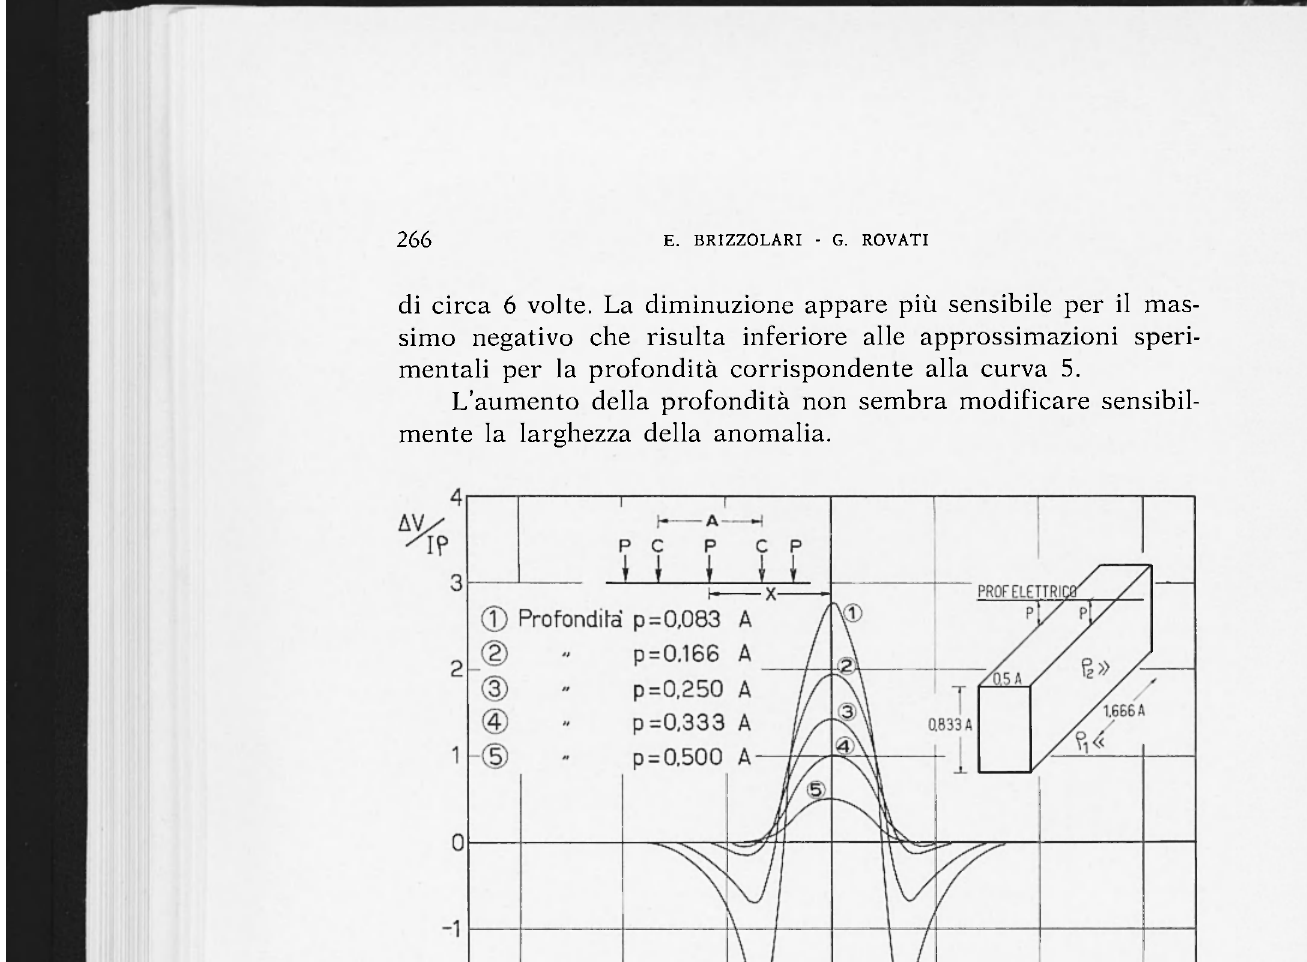
FIG. 2: Anomalie al variare della profondità. Spessore, al- tezza e larghezza